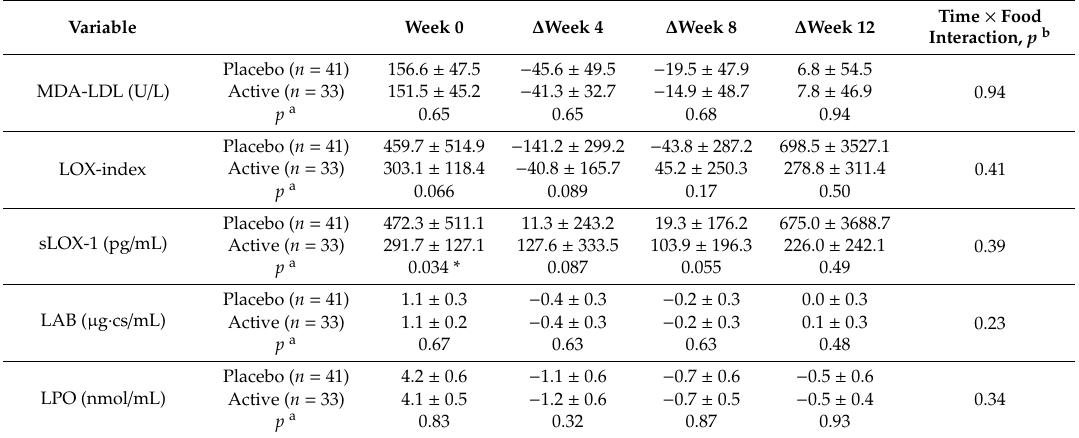
Table 7. Oxidative marker levels for the placebo and active food test